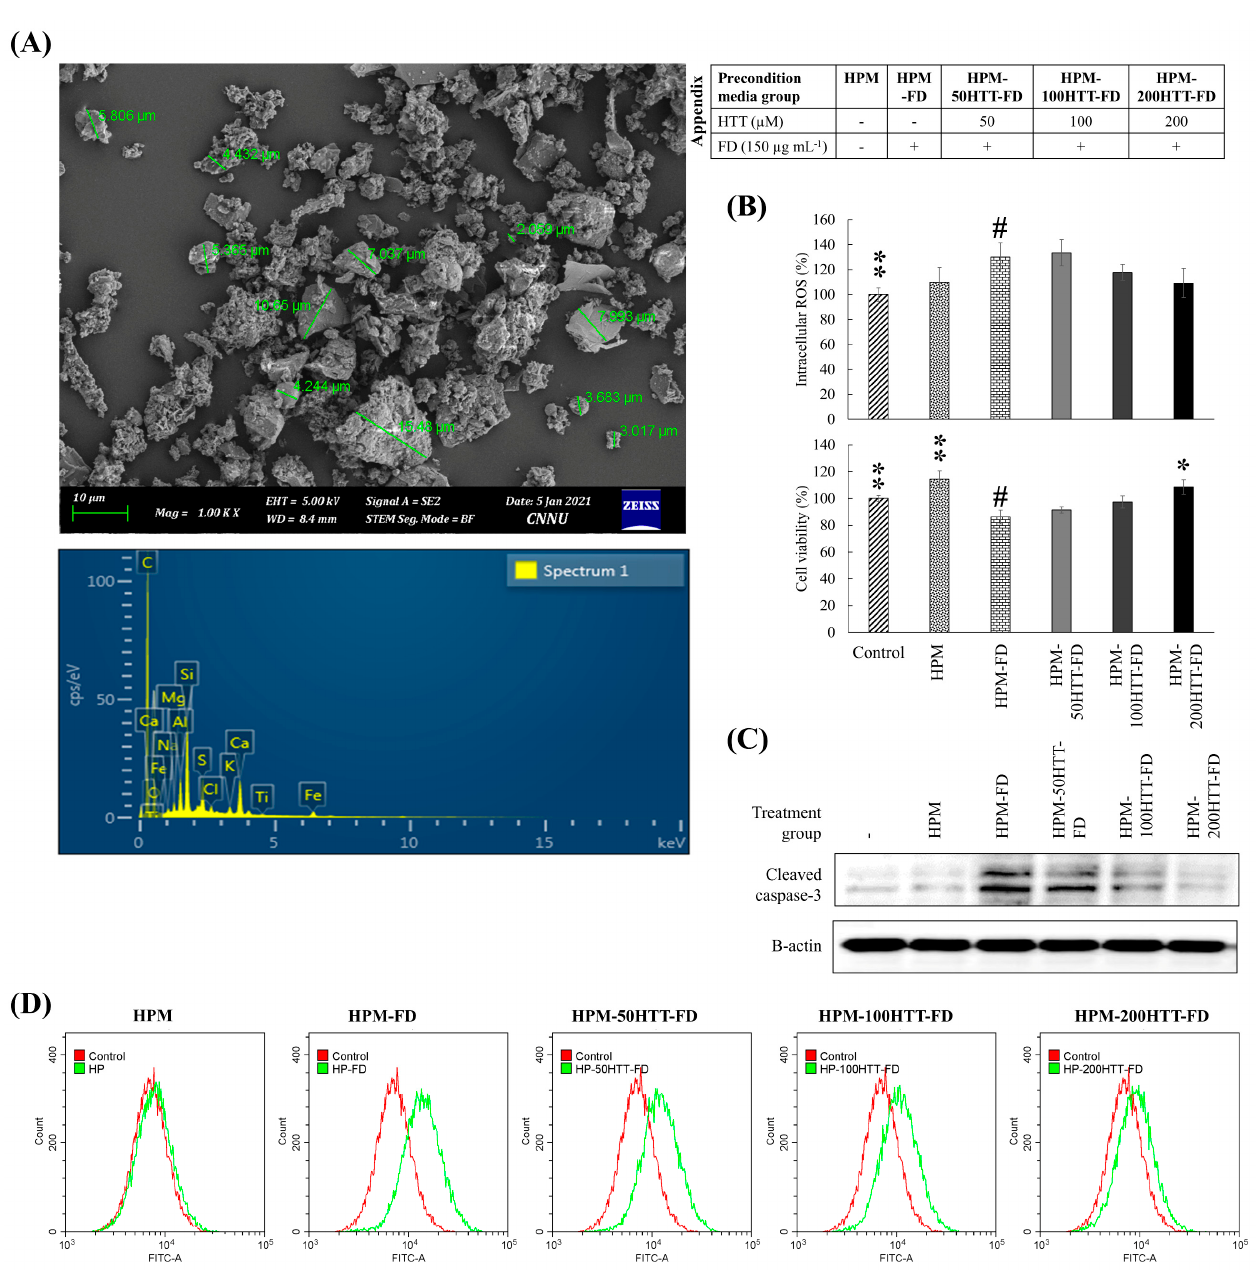
Figure 1. Effect of HTT priming in FD-stimulated HaCaT keratinocyte preconditioned media on producing ROS in integrated HDFs and cytotoxicity. ( A ) SEM secondary electron image of the particle size distribution of FD and SEM-EDX analysis of FD. ( B ) Intracellular ROS level and viability of HDFs. ( C ) Levels of cleaved caspase-3. ( D ) Evaluation of intracellular ROS levels in HDFs by flow cytometry. HDFs were stimulated for 2 h with preconditioned media from FD-stimulated HaCaT keratinocytes with and without HTT pre-treatment. Intracellular ROS levels were measured 2 h after the stimulation period. Cell viability was evaluated after 24 h. Evaluations were carried out in triplicates ( n = 3) and indicated as means ± SD. “*” and “**” respectively denote p < 0.05 and p < 0.01 if they are significantly different from those of HPM-FD treated HDFs “#”.